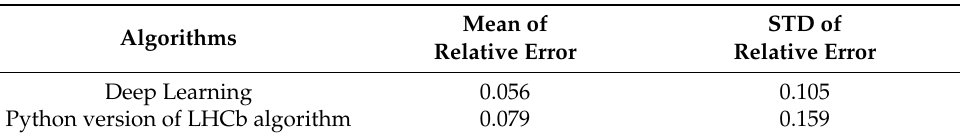
Table 4. Results concerning the mean value and standard deviation of the relative error measured as the difference of energy reconstructed per cluster from a total of 200 simulated events.